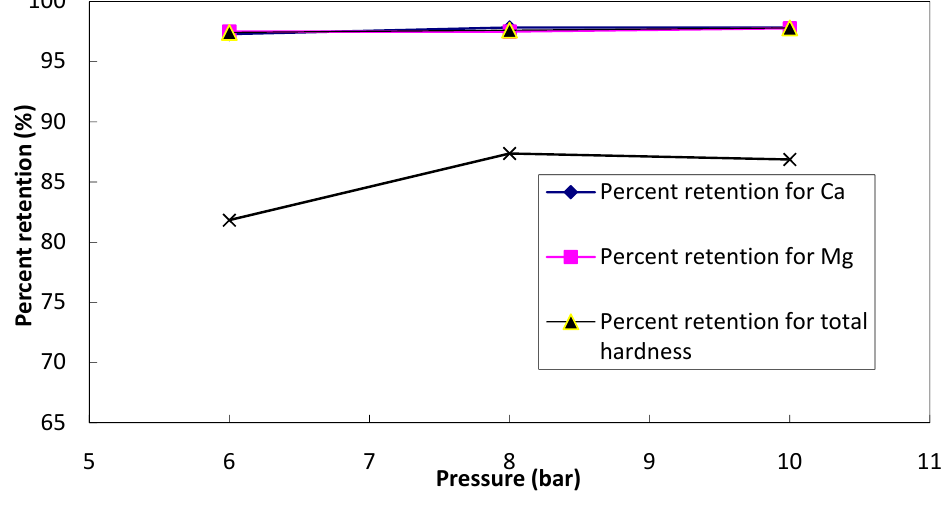
Figure 4. Retention of Ca 2+ , Mg 2+ , total hardness and TDS vs. pressure for Sample 2.